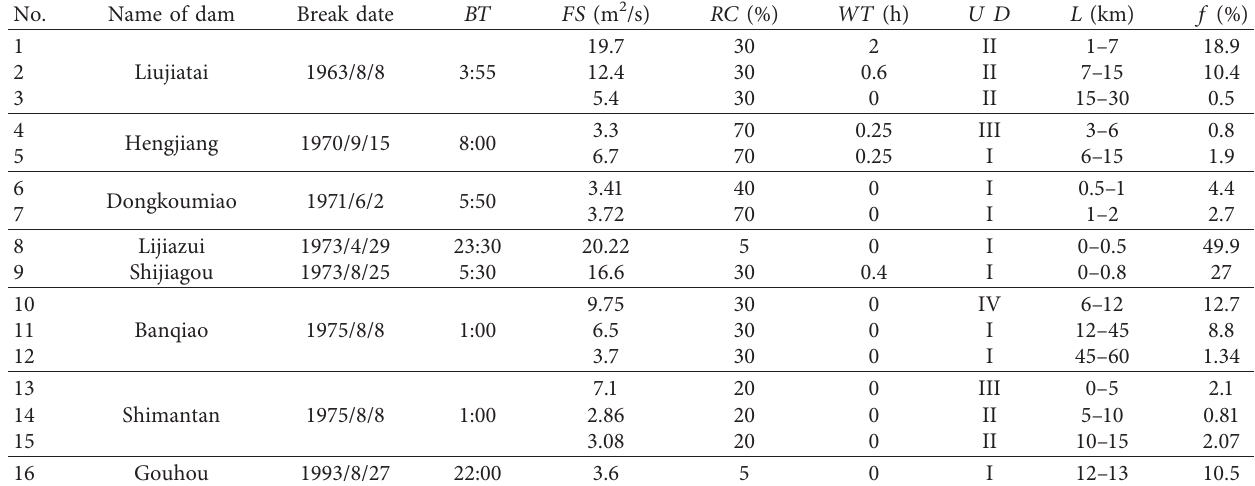
Table 2: Sample data of life loss caused by dam-break